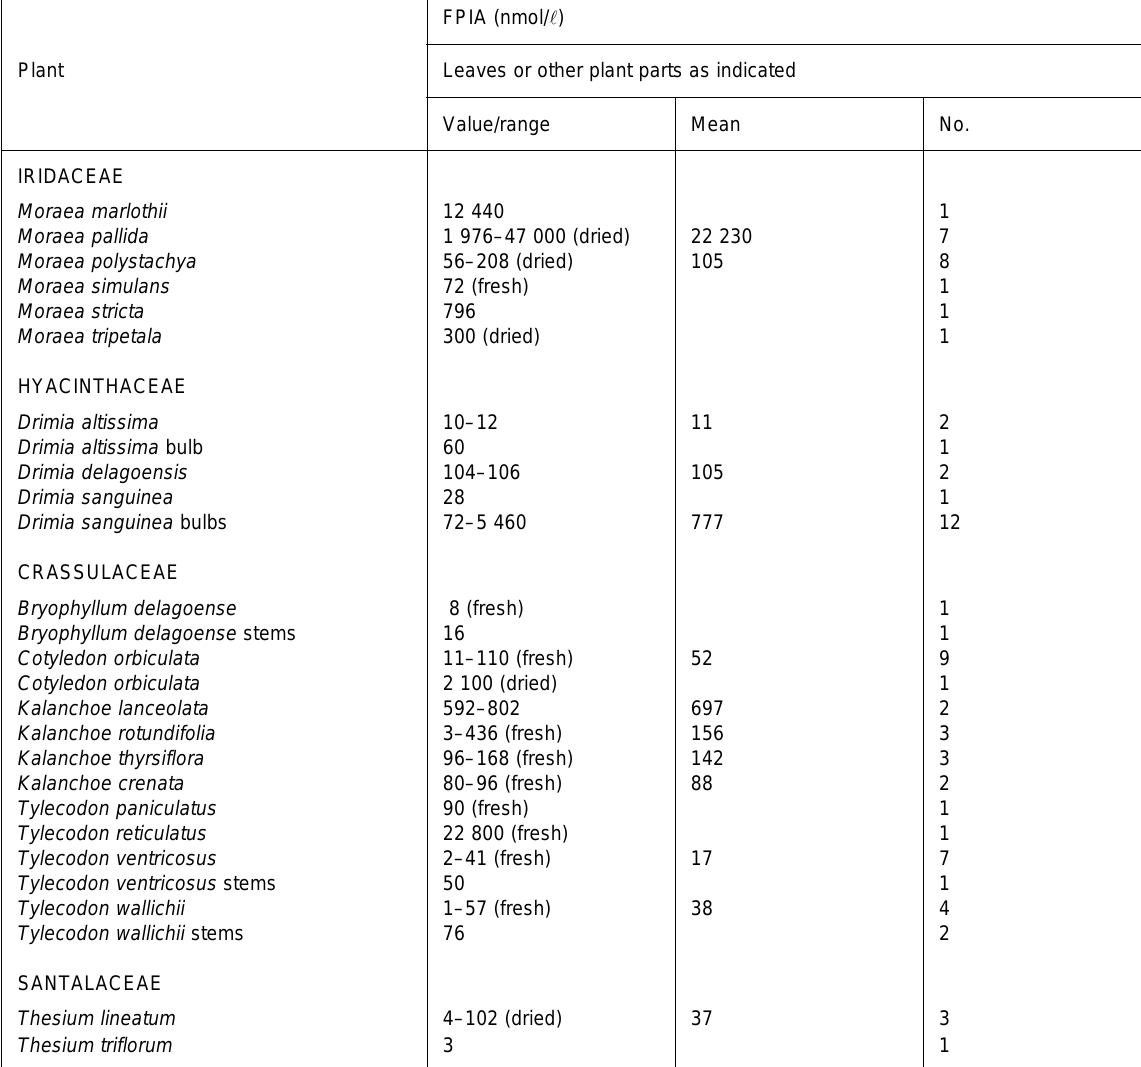
TABLE 1 FPIA values in bufadienolide-containing plants FPIA (nmol/ l ) Plant Leaves or other plant parts as indicated Value/range